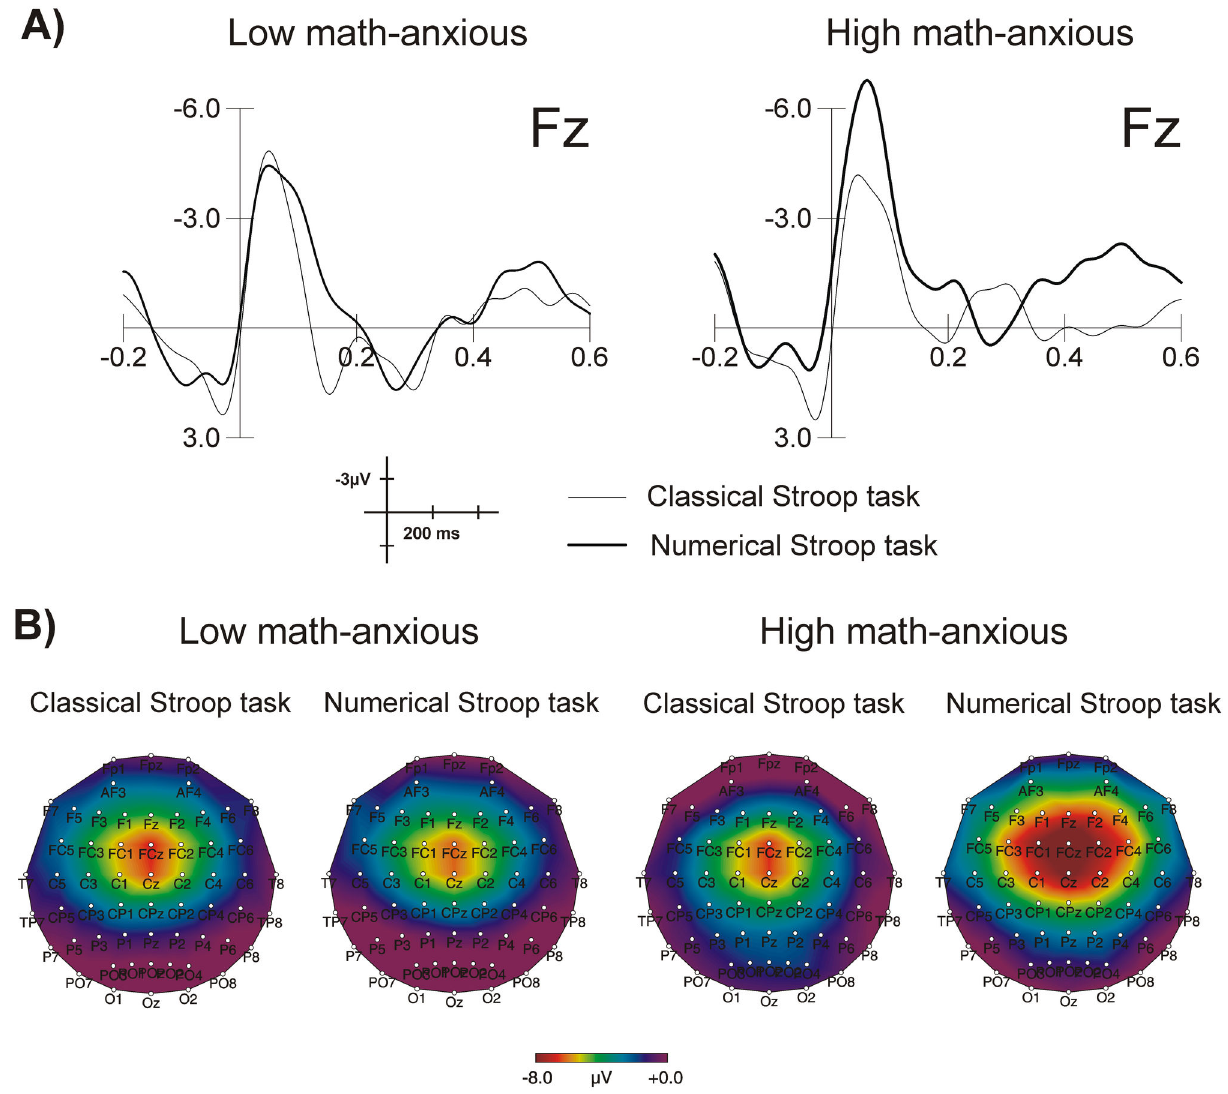
Figure 3. Image of error-related brain potentials. Grand average waveforms for the ERN at Fz for the LMA and the HMA groups in the numerical and the classical Stroop tasks (A) and scalp topography of the ERN component in the 50-90 ms window after the commission of an error for the LMA and the HMA groups in the classical and numerical Stroop tasks (B). doi: